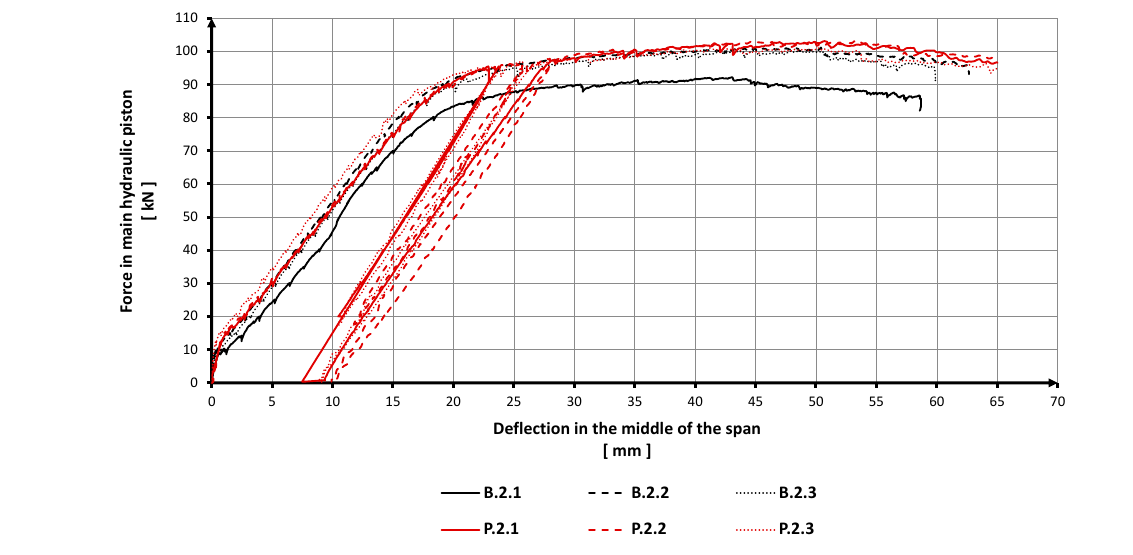
Table 6. Summary of breaking forces for each batch of RC beams.